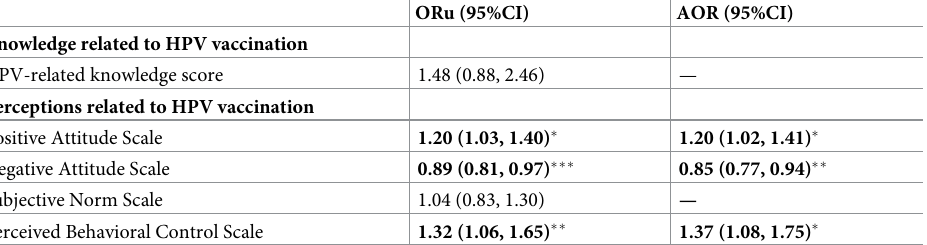
Table 4. Factors associated with recommendation of HPV vaccination to any STD clinic attendees (either male or female) in the last 12 months (n = 98).